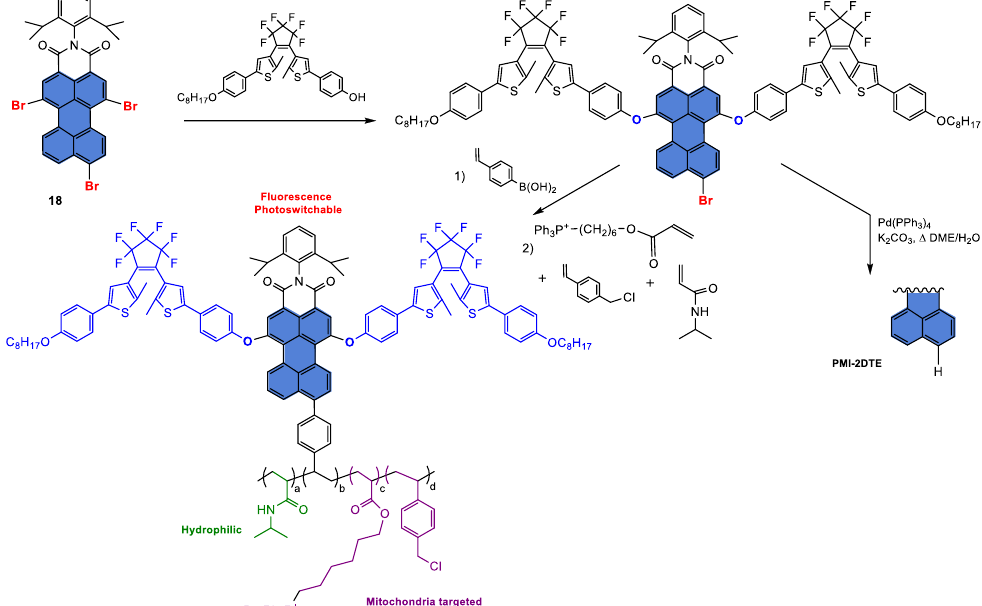
and fluorescence switching occurring upon irradiation with visible and ultraviolet light.